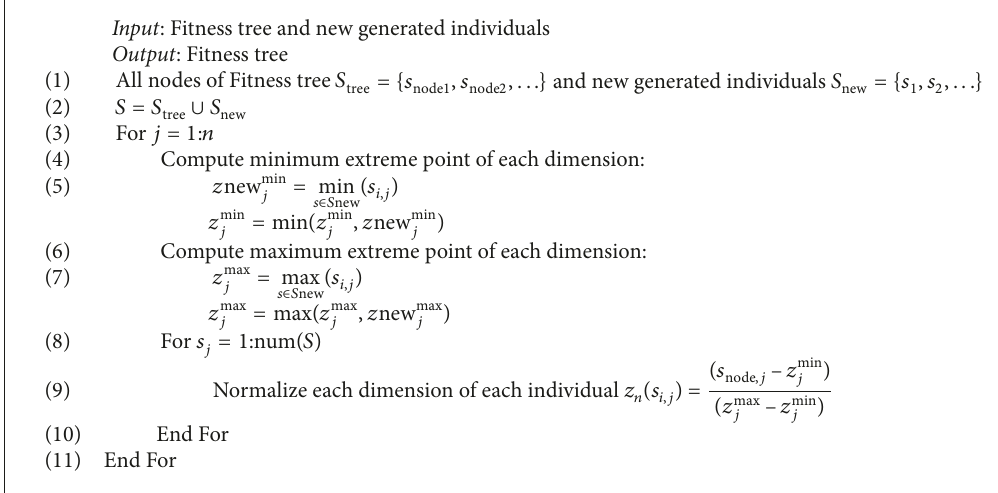
Algorithm 2: Pseudocode of adaptive normalization of population